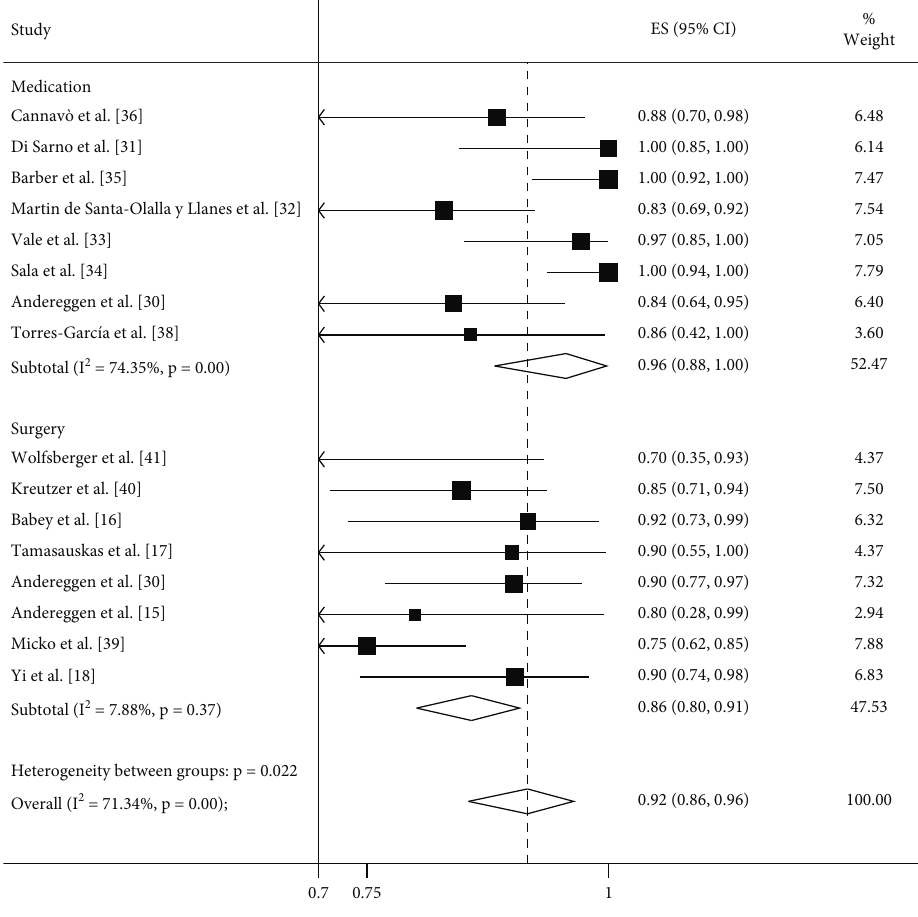
Figure 3: Meta-analysis of remission rates comparing surgery and medical treatment in microprolactinomas at ≥ 12 months of follow-up. The remission rate was achieved in 86% of patients treated with surgery and 96% of patients treated with DAs ( P � 0 . 019) at ≥ 12 months of